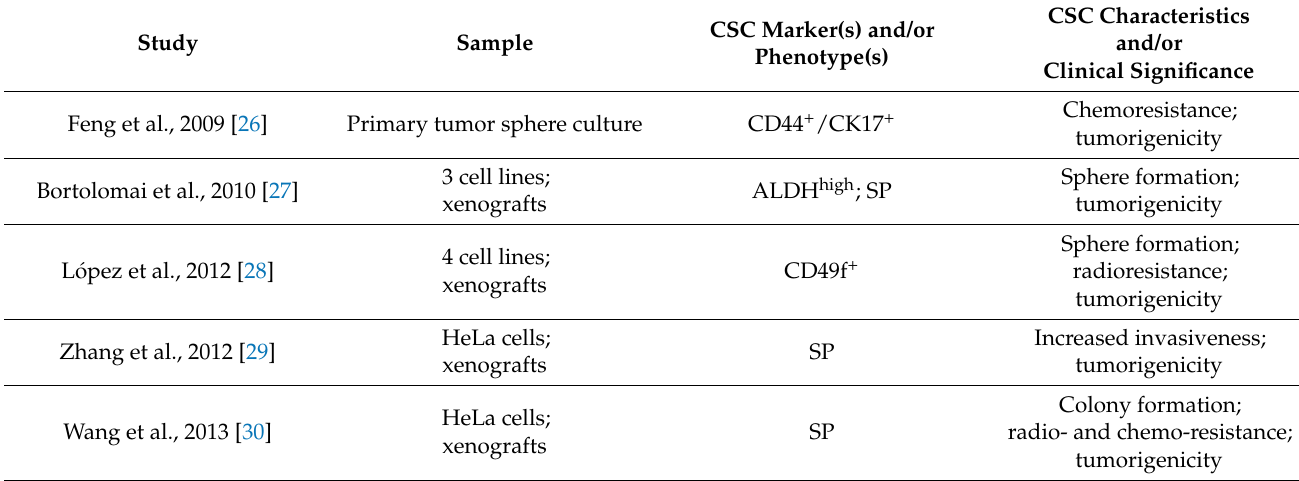
Table 1. A selection of published studies on CSCs in human cervical